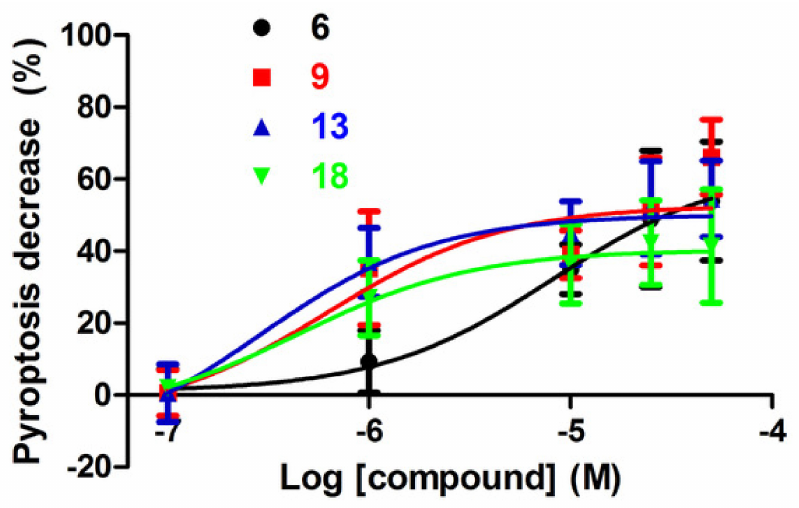
Figure 3. Concentration-response curves for the effects of compounds 6 , 9 , 13 and 18 on the ATP- triggered cell death of differentiated THP-1 cells. PMA-differentiated and LPS-primed THP-1 cells were pre-treated with vehicle alone or indicated compound. Each compound was added at increasing concentrations (0.1 − 50 µ M) 1 h before exposure to ATP (5 mM; 90 min). LDH activity was measured in the collected supernatant by a colorimetric assay. Data are expressed as decrease of cell death vs. vehicle alone and are the mean ± SEM of at least three experiments run in triplicate.